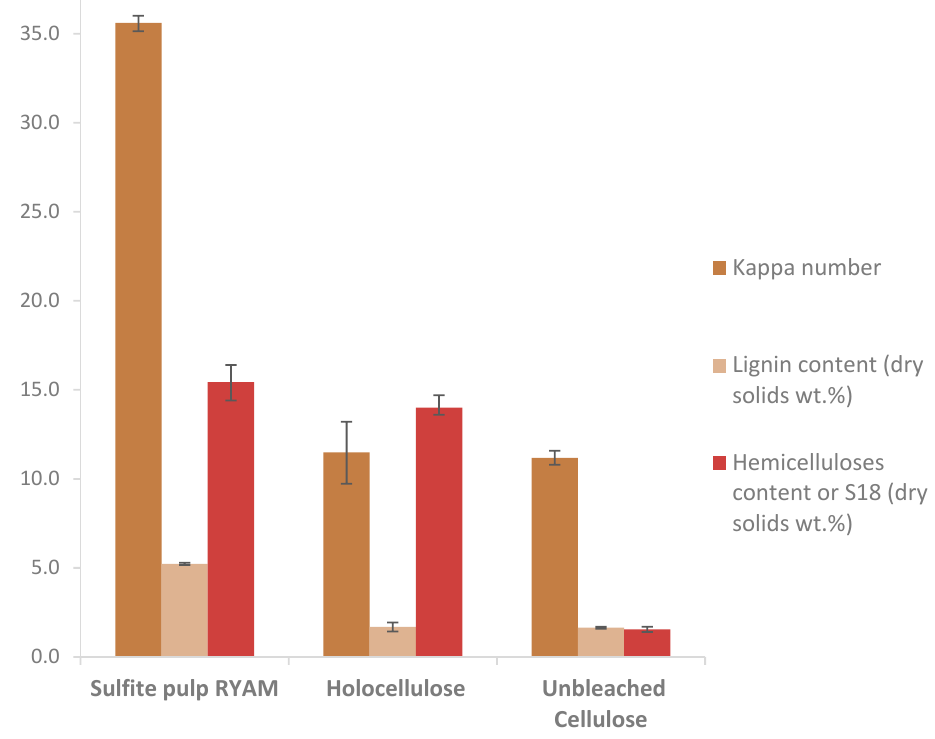
Figure 2. Evolution of the lignin and hemicellulose contents in pulps during extraction. For the delignification step leading to the holocellulose, 1.7 wt.% lignin was